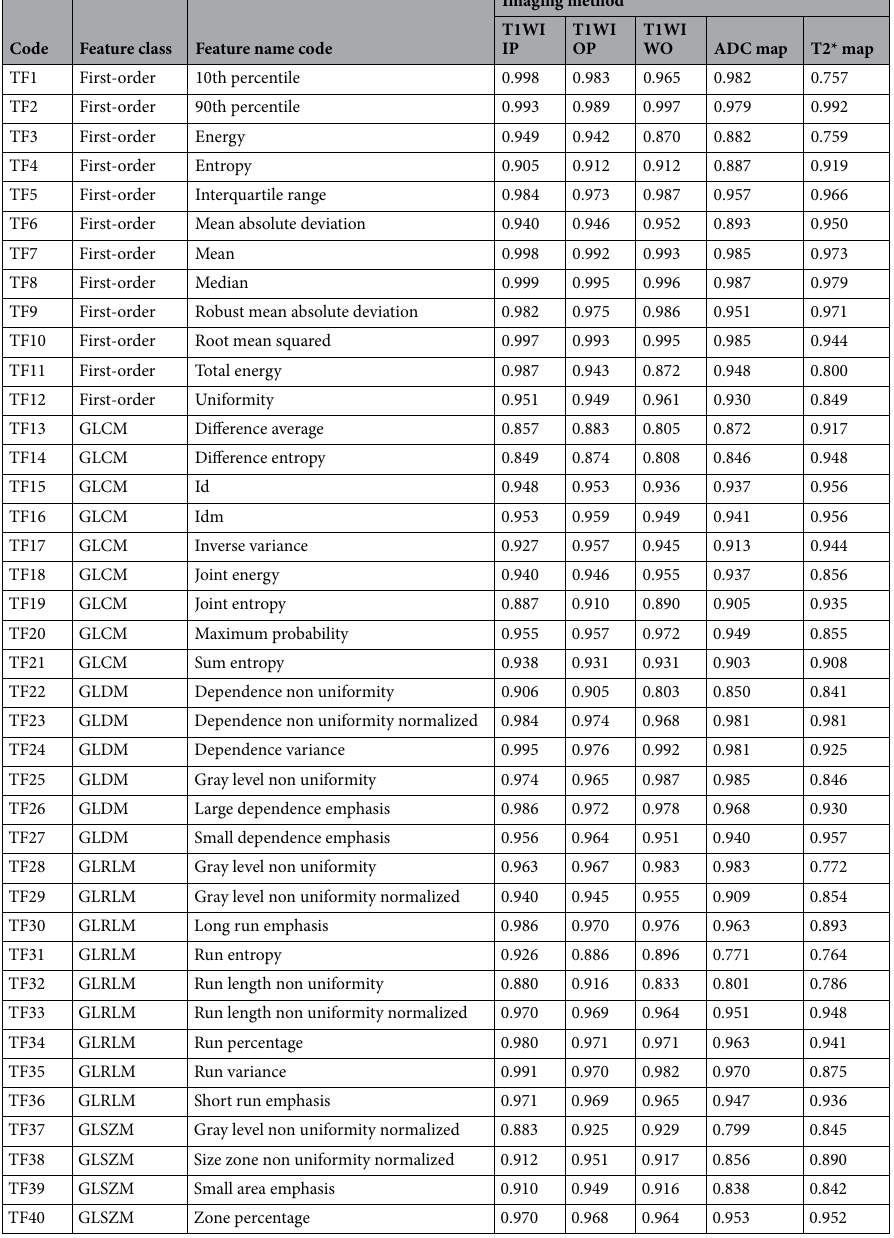
gray-level run length matrix, GLSZM gray-level size zone matrix, IP in-phase, OP opposed-phase, TF texture feature, WO